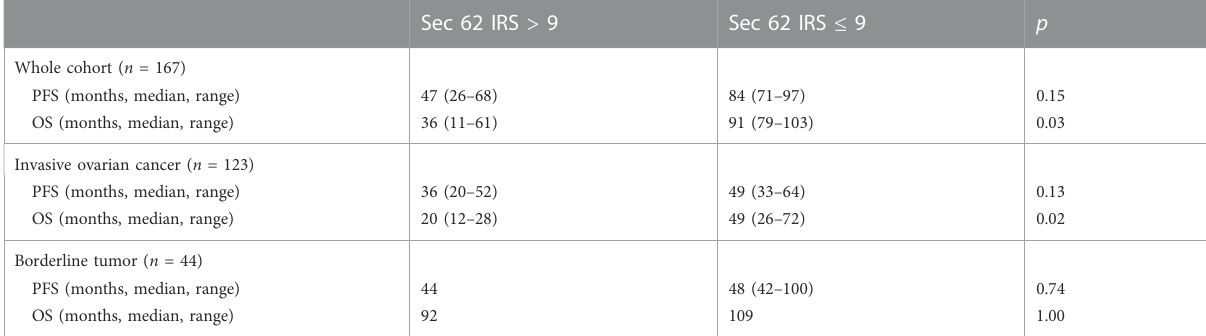
TABLE 4 Oncologic outcomes in correlation with immunohistochemical SEC 62 expression (PFS = progression-free survival, OS = overall survival, IRS = immunoreactive